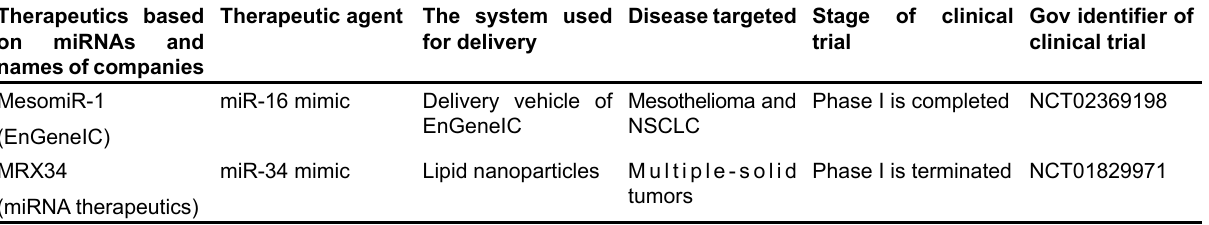
Table 1. List of miRNAs based therapeutics in their clinical trials ( continued ) Therapeutics